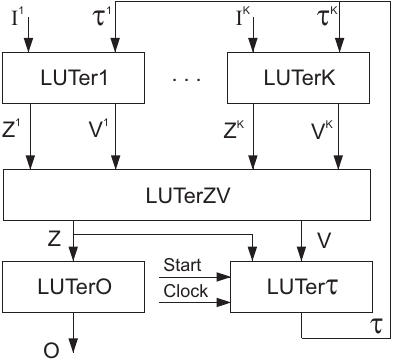
Figure 29. The structural diagram of LUT-based P oT Y Mealy FSM.